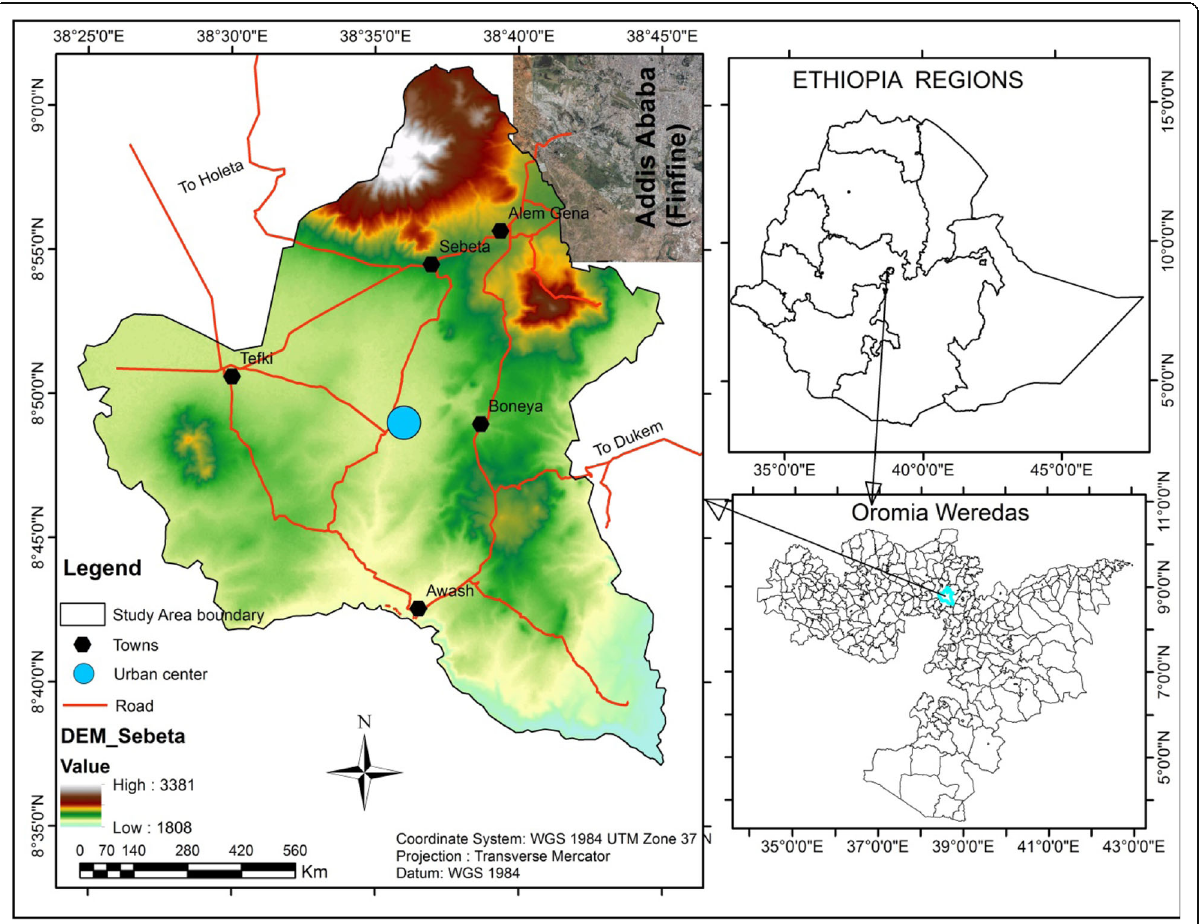
Fig. 1 Location and topography of the study